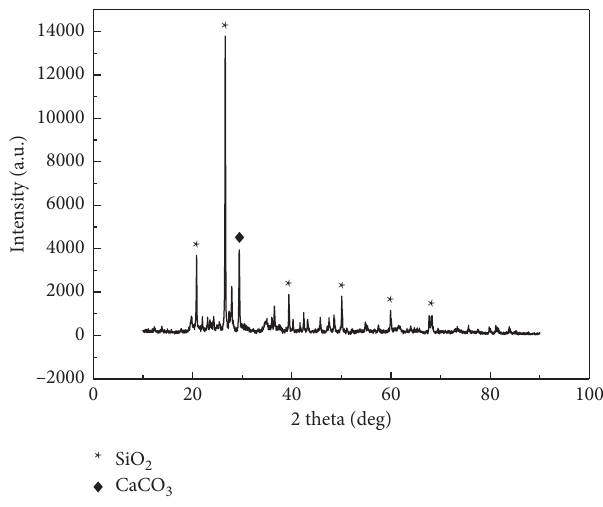
Figure 1: XRD diagram of shield